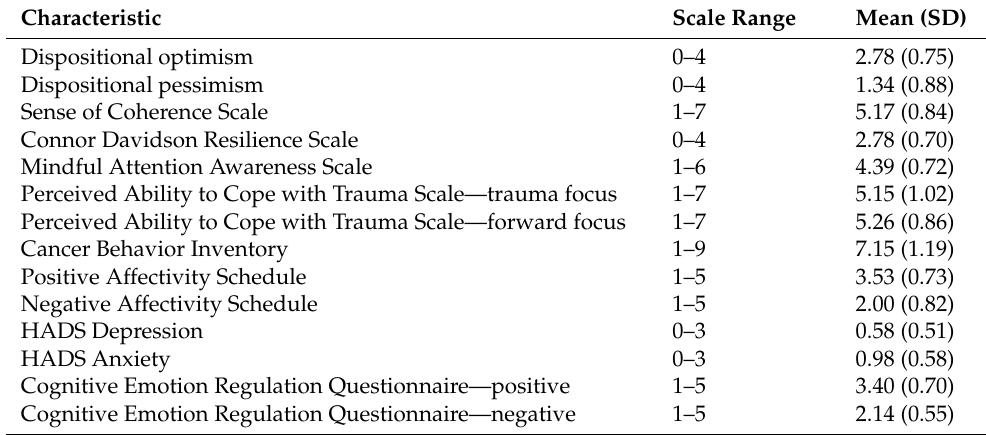
Table 3. Distribution of psychological predictor variables (N =